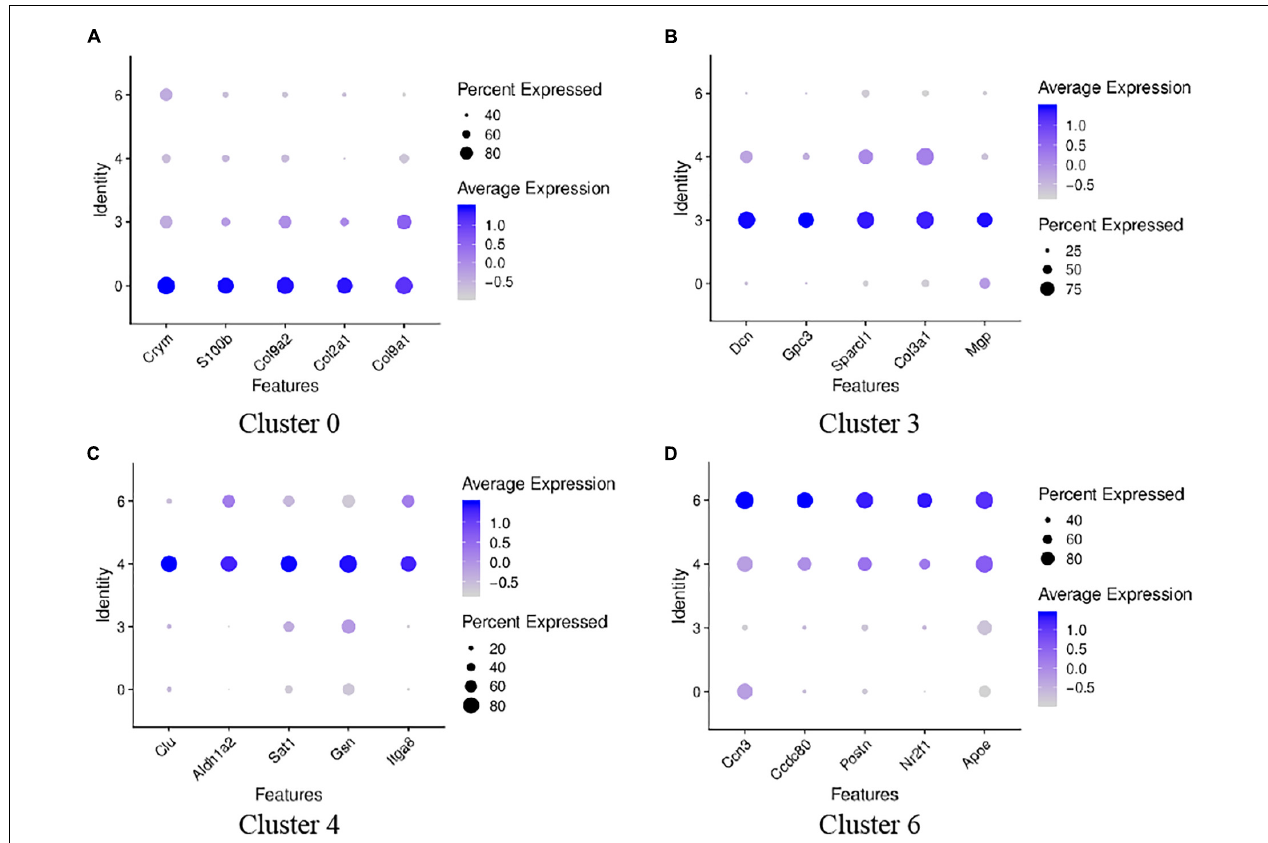
FIGURE 8 | Dot plots representing expression levels of the four GER cells. A re-clustered analysis was performed to reveal the heterogeneity of differential genes expression. Expression levels of the top five genes on cluster 0 (A) , cluster 3 (B) , cluster 4 (C) , cluster 6 (D) are shown. Each dot was sized to represent the proportion of cells of each type expressing the marker gene and colored to represent the mean expression of each marker gene across all cells, as shown in the key.